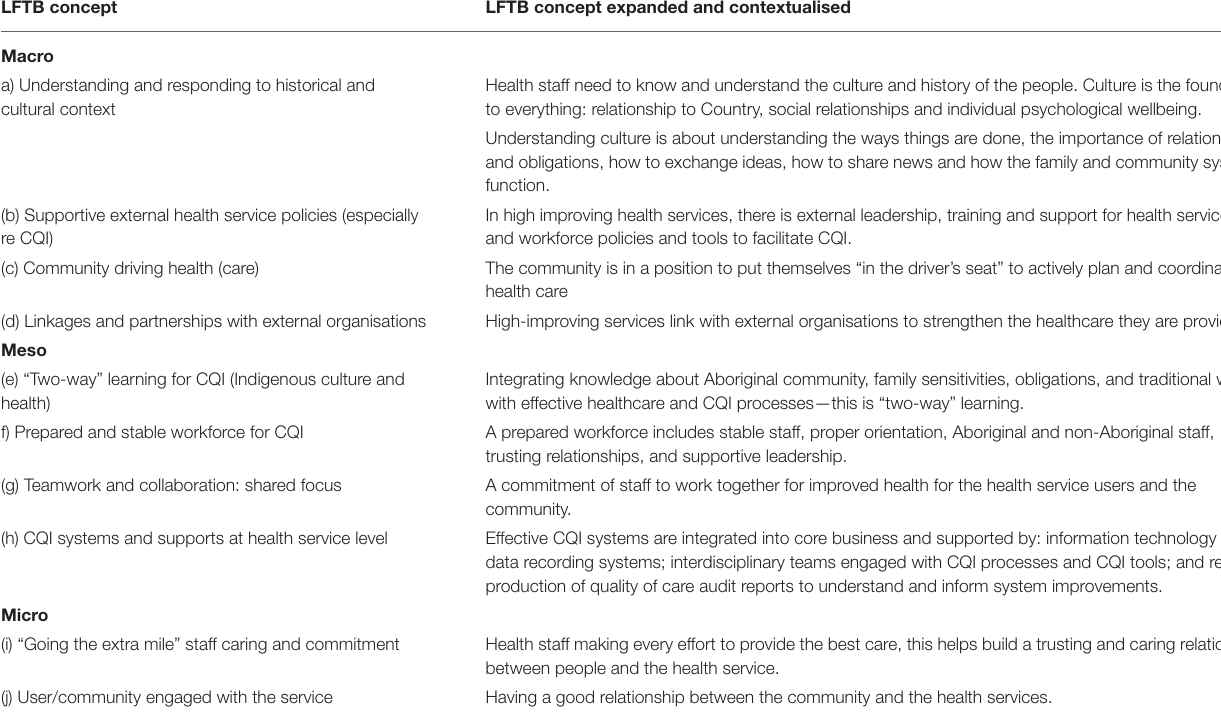
TABLE 1 | Expanded and contextualised concepts from “Lessons from the Best”